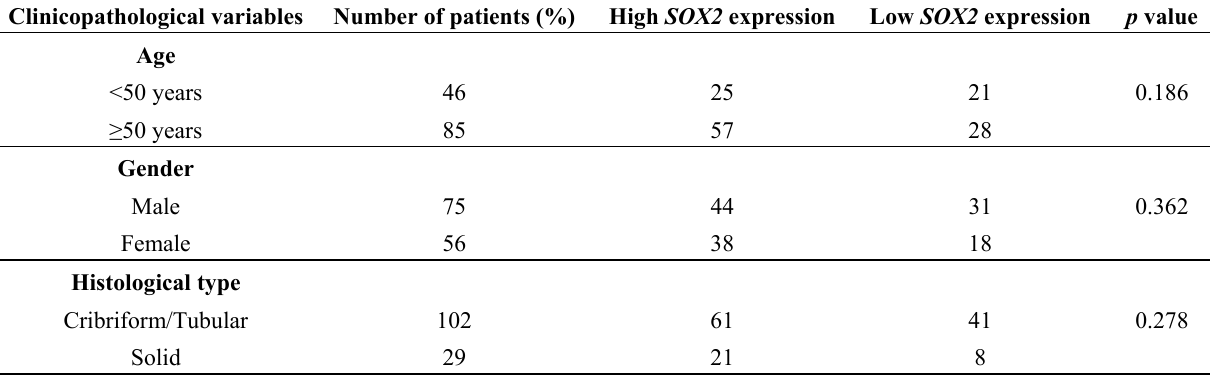
Table 1. Clinical characteristics according to SOX2 expression in